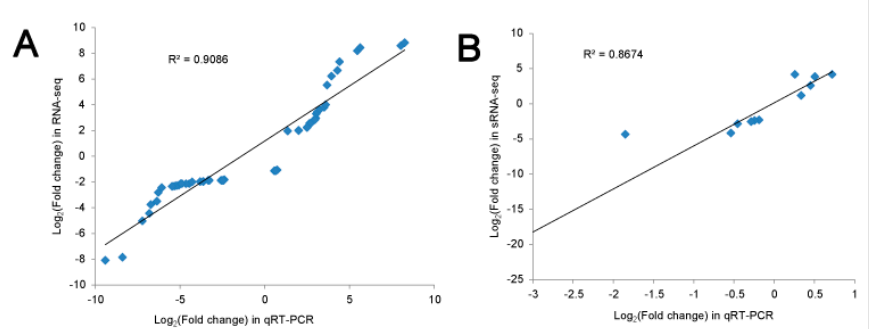
Figure 8. Comparison of gene expression values obtained from RNA-seq, sRNA-seq and quantitative real-time PCR (qRT-PCR) results. ( A ) Log 2 (fold change) were calculated for 17 DEGs, and a high correlation ( R 2 > 0.93, P < 0.01) was observed between RNA-seq and qRT-PCR results. ( B ) Similarly, Log 2 (fold change) for 12 differentially expressed miRNAs were calculated, and the correlation ( R 2 > 0.86, P < 0.01) was showed between sRNA-seq and RT-qPCR results.